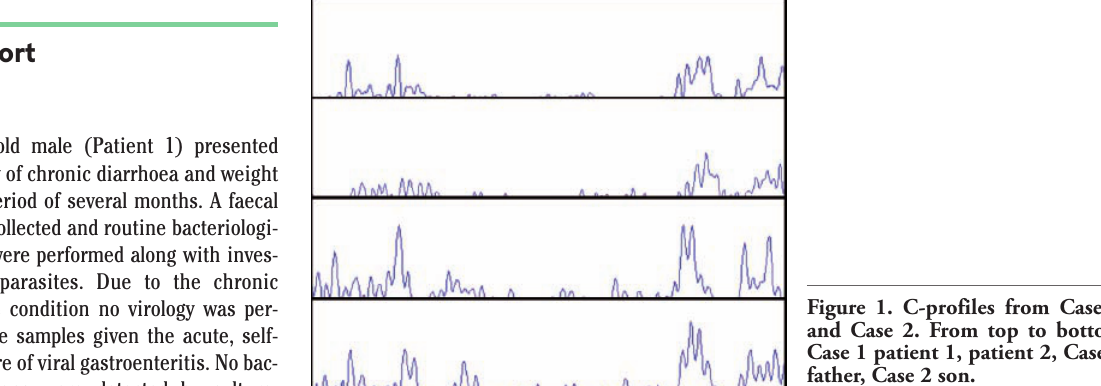
Figure 1. C-profiles from Case 1 and Case 2. From top to bottom Case 1 patient 1, patient 2, Case 2 father, Case 2